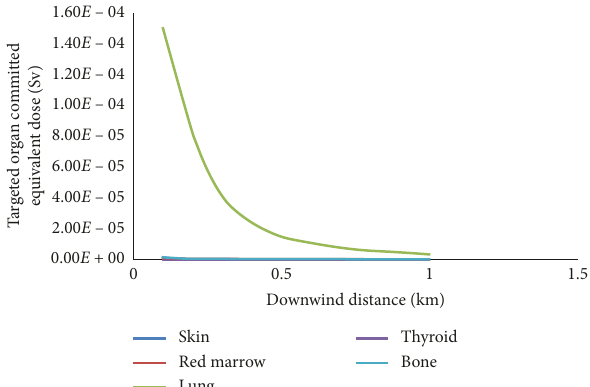
Figure 6: Target organ committed equivalent dose as a function of downwind